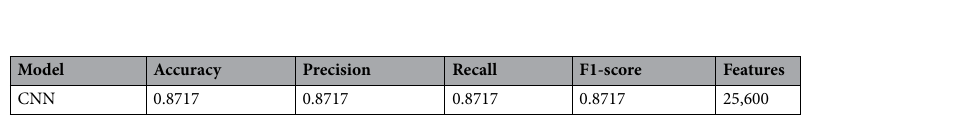
Table 6. Performance evaluation of the classification accuracy, precision, recall and F1-score for the CNN model, using all extracted features and softmax function for classification.